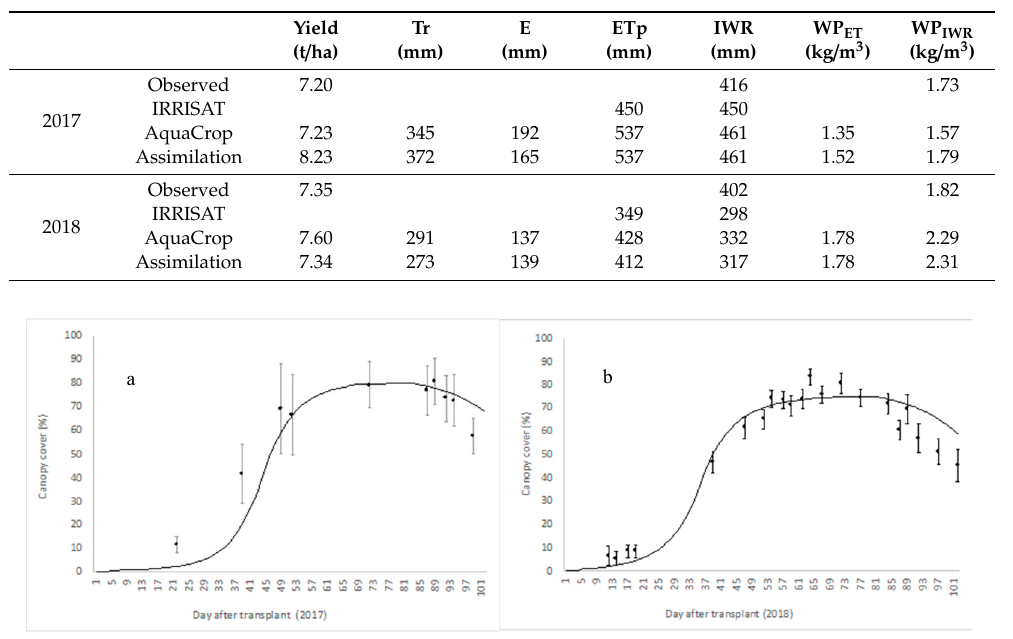
Figure 4. Canopy cover of tomato simulated by AquaCrop, after calibration with field data (line) and corresponding fractional cover values (dots) retrieved by Sentinel-2 imagery during 2017 ( a ) and 2018 ( b ) growing seasons, with corresponding standard deviations. Table 4. Evaluation of canopy cover simulation results: Number of observations/simulations (n), Pearson correlation coefficient (r), root mean square error (RMSE%), Nash–Sutcliffe model efficiency coefficient (EF) and Willmott index of agreement (d).